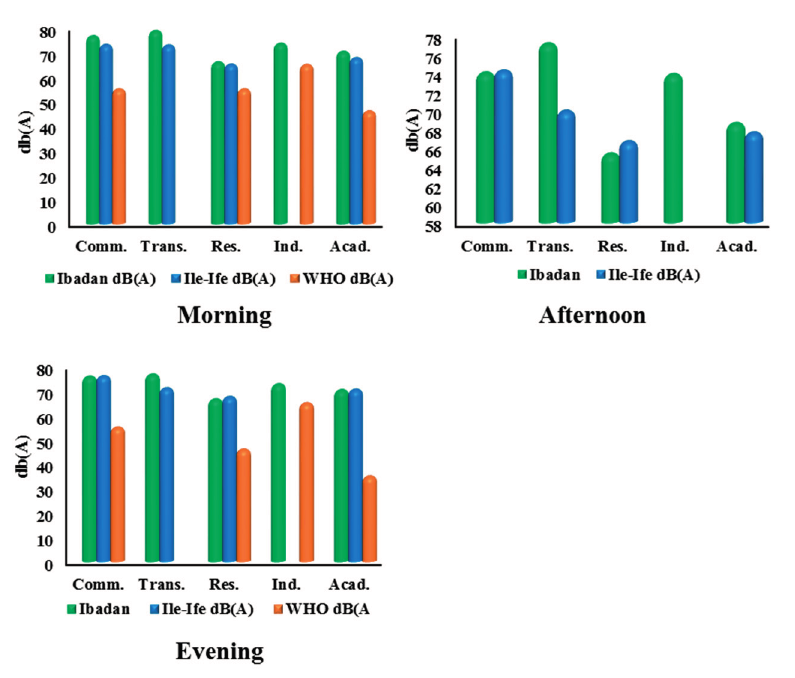
Figure 11. Comparative mean of daily noise levels across land uses in Ibadan and Ife-Ife.